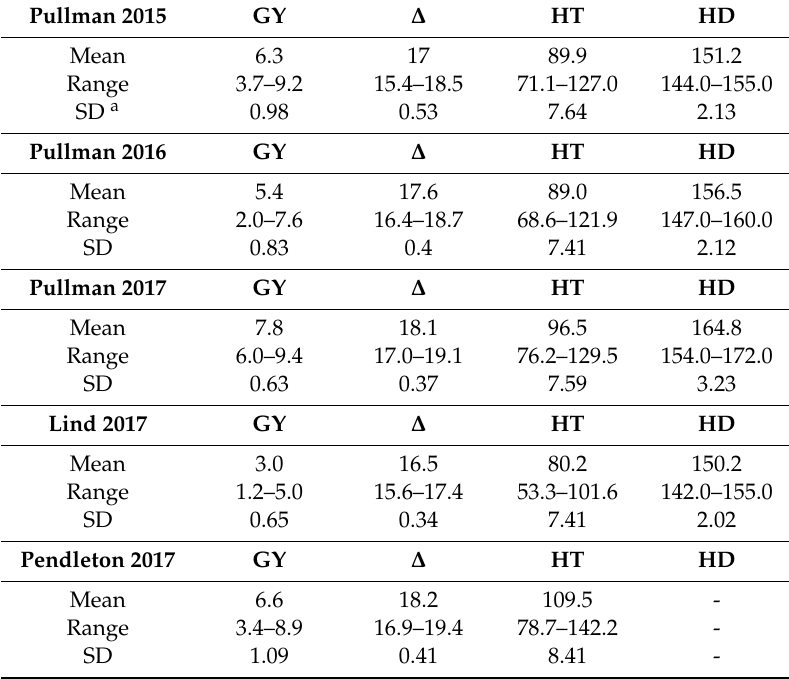
Table 1. Data summary for grain yield (GY, t ha − 1 ), ∆ (carbon isotope discrimination, per mil), plant height (HT, cm), and heading date (HD, Julian) collected on a panel of 480 advanced soft white winter wheat lines adapted to the Pacific Northwest.